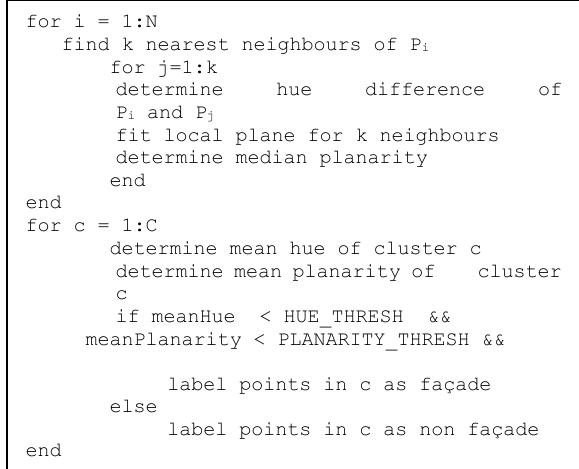
Table 1. Pseudo code for radiometric